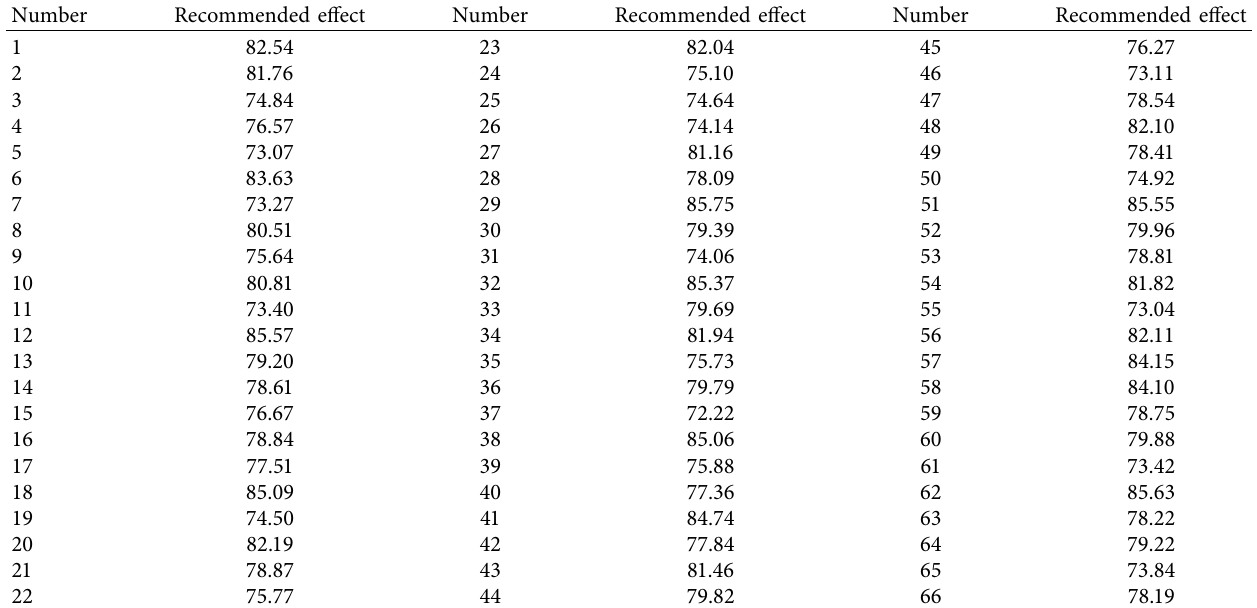
Table 2: Personalized recommendation effect evaluation of online shopping product personalized recommendation system based on online fast learning through latent factor